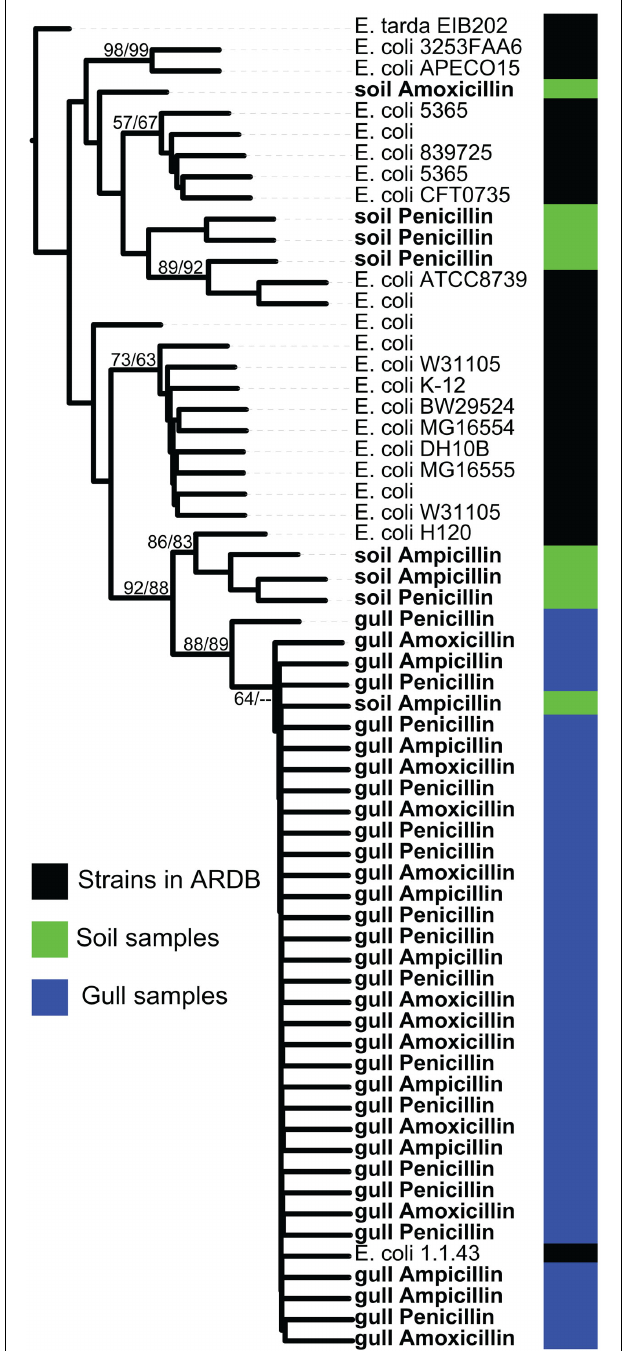
FIGURE 3 | Phylogenetic tree of the bl1_ec type class C β -lactamase gene from metagenomic clones and sequenced representative strains fromARDB. The sequenced clones are from samples from gulls or soil, whereas we did not detect any bl1_ec type clones in samples from wastewater. Metagenomic clones were isolated on ampicillin, amoxicillin, or penicillin as listed for each entry.The phylogenetic tree is a majority rule consensus tree based on protein similarity using neighbor-joining. Bootstrap values (total 100) are calculated with neighbor-joining and maximum likelihood methods. Edwardsiella tarda sp. EIB202 is the